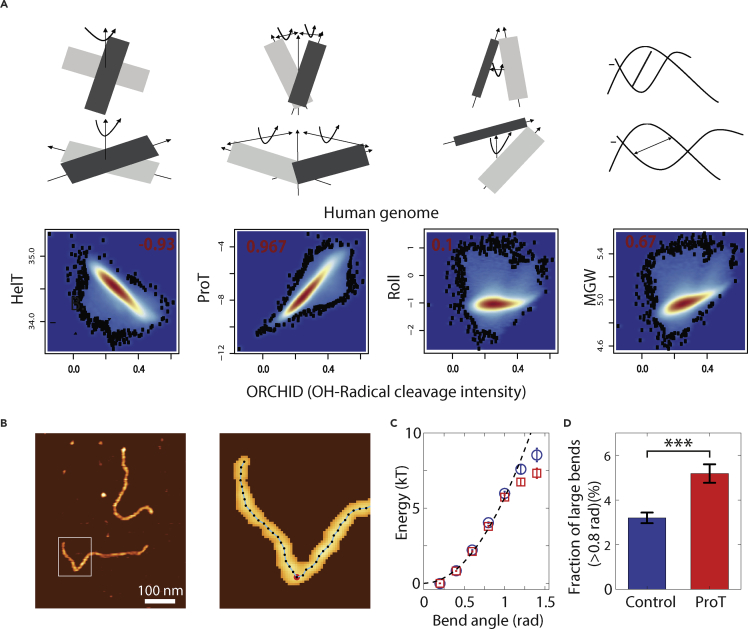
DNA Surface Accessibility and Flexibility Are Encoded in Its Biophysical Features(A) Human genome-wide correlations of predicted values of DNAshape features; helix turn (HelT), propeller twist (ProT), roll (Roll), and major groove width (MGW) with surface accessibility of the DNA as measured by OH-radical cleavage intensity predictions.(B) Typical AFM topographic image depicting two linear DNA molecules (left). Enlarged view of the boxed area (left) superimposed with the traced contour (right). The red point highlights the location of a large bend (>0.8 rad).(C) Energy landscape for bend angles reconstructed from the bend angle distribution for pooled control (Nmolecules = 801) and pooled ProT (Nmolecules = 425) sequences. In total, we traced 87,168 bend angles from 1,226 imaged DNA molecules. The broken line depicts the energy landscape expected for a worm-like chain with persistence length P = 55 nm.(D) Fraction of large bends (>0.8 rad) for pooled control (Nlarge bends = 182; Nbends, total = 56,874) and high ProT (Nlarge bends = 157; Nbends, total = 30,294) sequences. The fraction of large bends is significantly higher for the ProT versus control sequences (p = 7.5 × 10-6). The error bar is the standard deviation from counting statistics, i.e. the square root of the counts divided by the number of total counts.See also Figure S1.